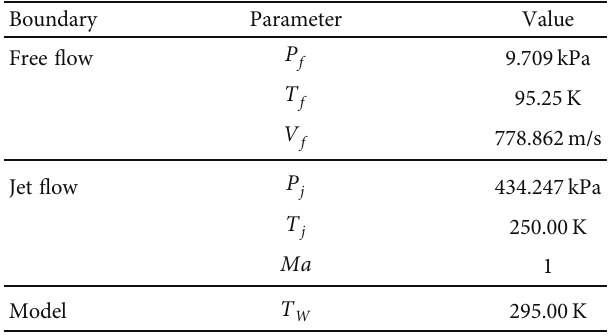
Table 2: Boundary conditions for validation.